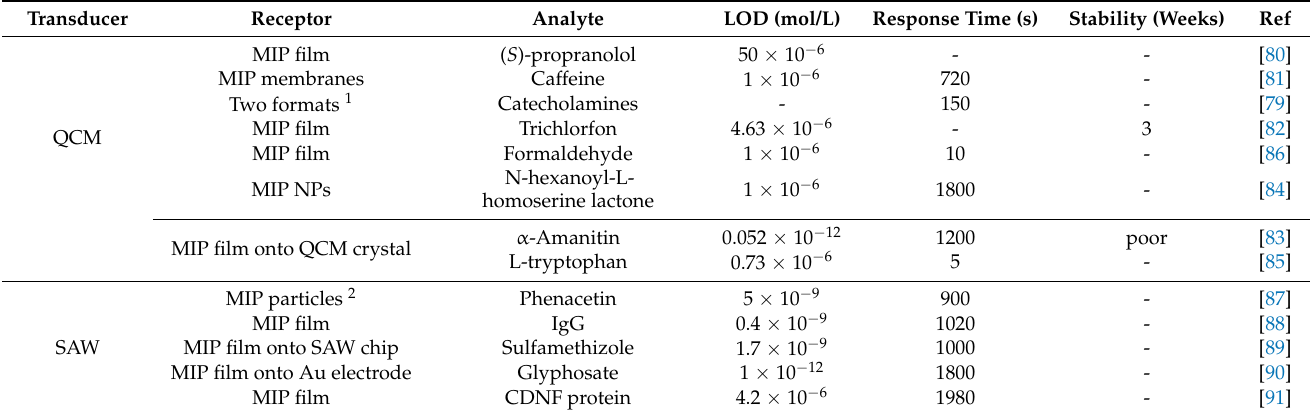
Table 2. MIP-based mass-sensitive